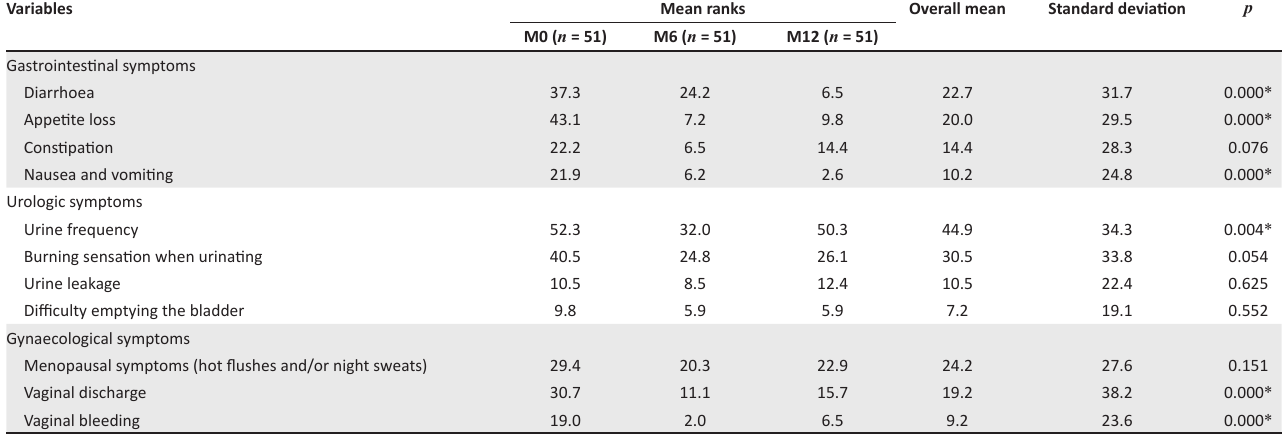
TABLE 5: Cervical cancer specific symptoms reported by the respondents per group ( n = 153). Variables